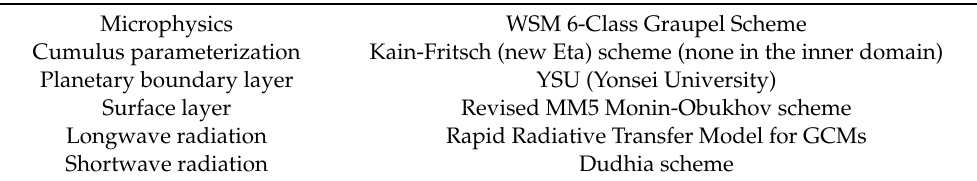
Table 1. Physical parameterization